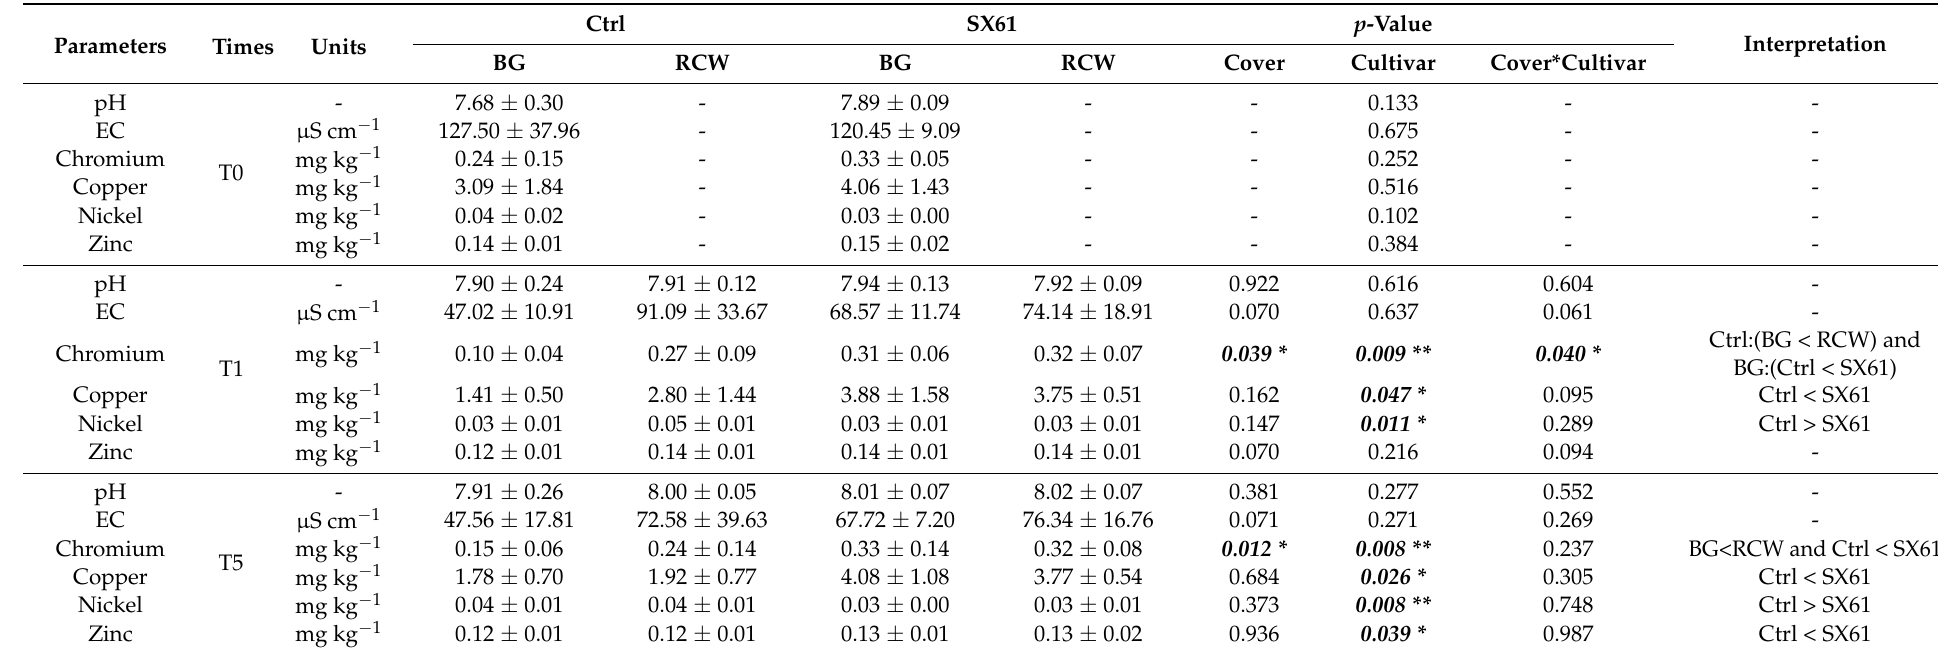
Table 4. Mean water extracted concentration of TEs, pH and EC in soil over